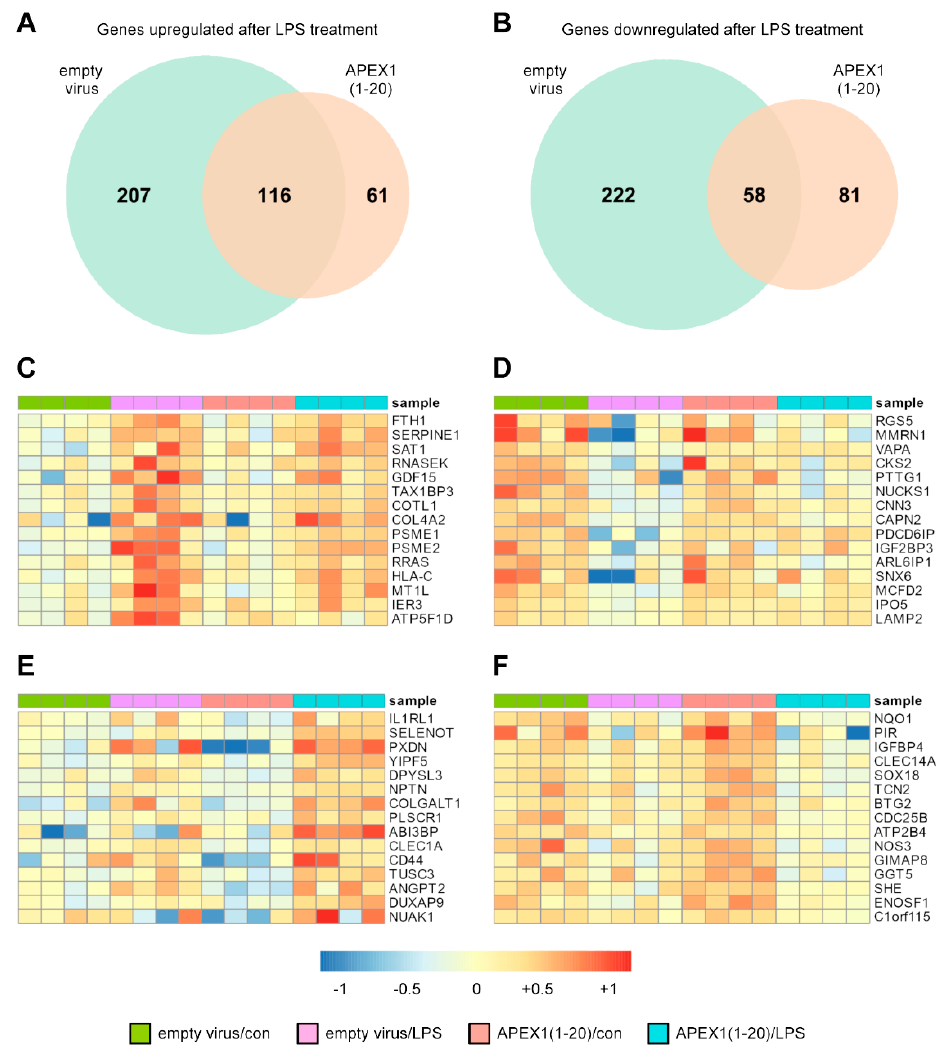
Figure 1. APEX1(1-20) induces specific transcriptome changes in EC in response to LPS. ( A – F ) EC were transduced with a lentiviral expression vector for APEX1(1-20) or an empty virus and treated with 150 ng/mL detoxified (con) or active LPS (LPS) for 18 h. RNAs from the transduced cells were subjected to RNA deep sequencing. Differential gene expression was calculated using the R package DESeq2. Wald test from DESeq2 was used to calculate the significance of the change in the expression. ( A , B ) Venn-diagrams for genes upregulated ( A ) or downregulated ( B ) after LPS treatment of empty virus transduced cells and cells expressing APEX1(1-20). ( C – F ) Heatmaps of genes significantly differentially expressed upon LPS treatment of cells transduced with the empty virus or cells expressing APEX1(1-20). Shown are the 15 top ranked genes from Supplementary Tables S7–S10. The color depicts the normalized expression relative to the respective mean in all samples. ( C ) Genes uniquely upregulated after LPS treatment of empty virus transduced cells. ( D ) Genes uniquely downregulated after LPS treatment of empty virus transduced cells. ( E ) Genes uniquely upregulated after LPS treatment of APEX1(1-20) expressing cells. ( F ) Genes uniquely downregulated after LPS treatment of APEX1(1-20) expressing